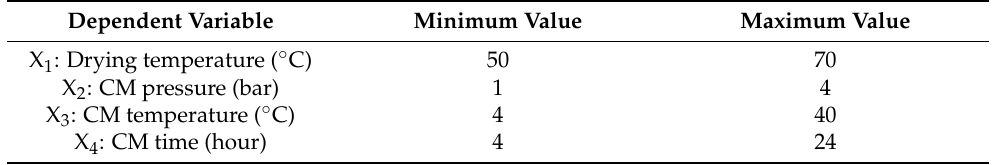
Table 1. Dependent variables of coded and uncoded values.